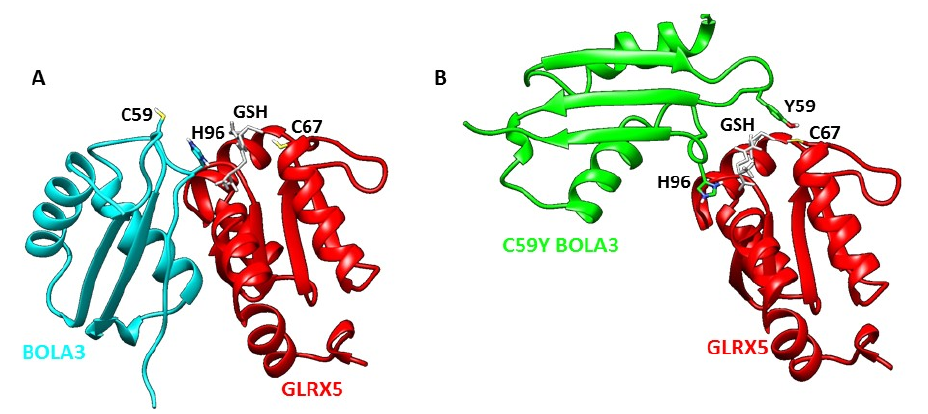
Figure 5. Visualizing the structure of the aberrant protein–protein complex by data-driven biomolecular docking. Structural models of apo BOLA3–GLRX5 ( A ) and C59Y BOLA3–GLRX5 ( B ) complexes. Ribbon diagrams of GLRX5, BOLA3, and C59Y BOLA3 structures are in red, cyan, and green, respectively. Sidechains of His96 and Cys59 in BOLA3, His96 and Tyr59 in C59Y BOLA3, Cys67 in GLRX5, and the GSH molecule bound to GLRX5 are shown as sticks.